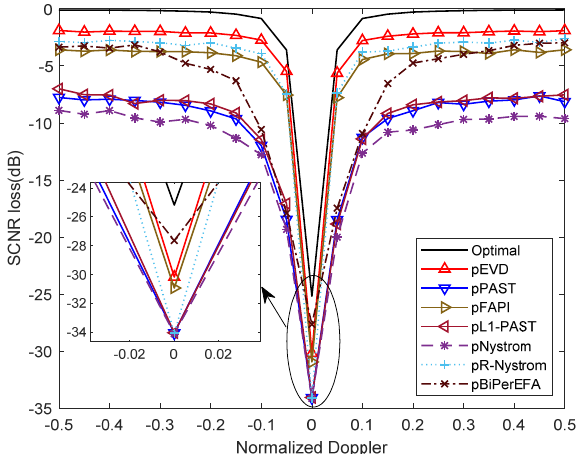
Figure 5. SCNR loss performance versus target Doppler frequency.